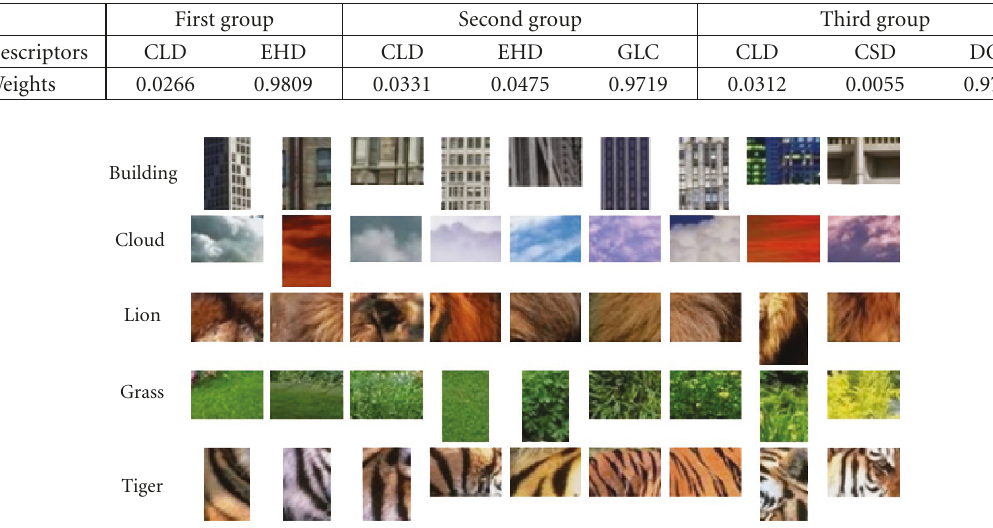
Figure 7: Samples of representative blocks considered for concepts: building, cloud, lion, grass , and tiger